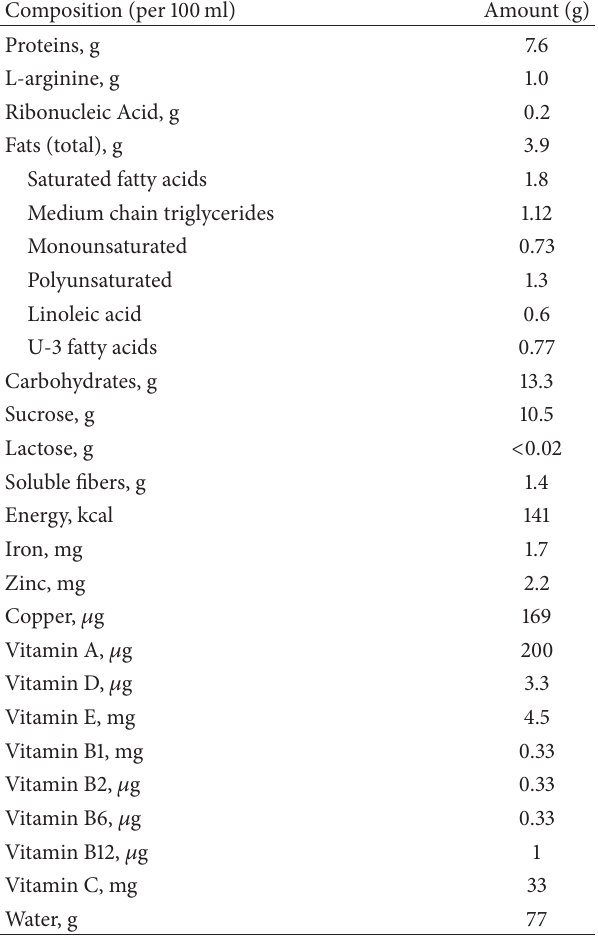
Table 1: Composition of